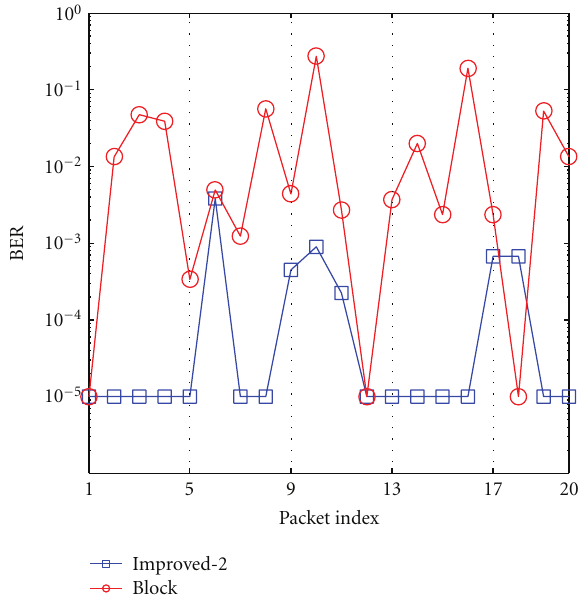
Figure 12: Performance of the proposed system with improved coarse timing estimation.